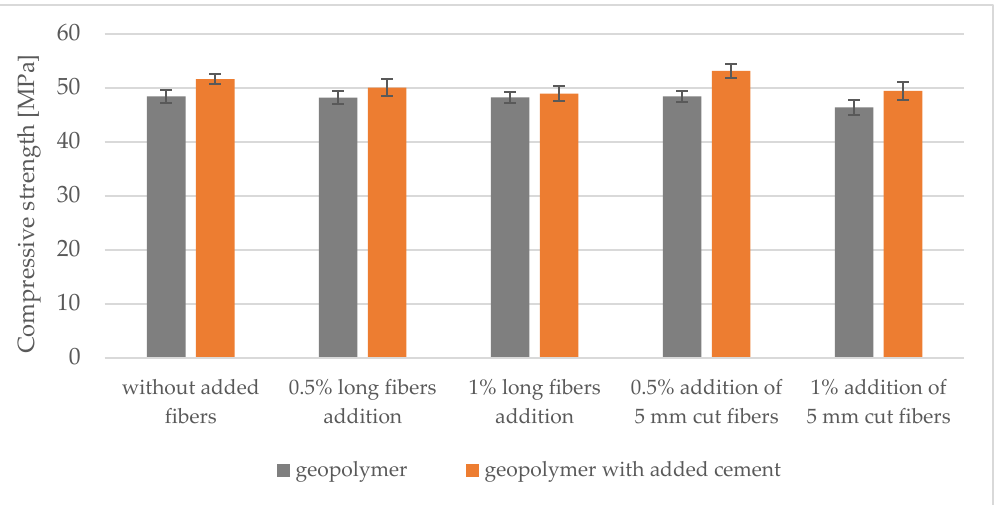
Figure 13. Compressive strength of geopolymers and cementitious geopolymers reinforced with carbon fiber.